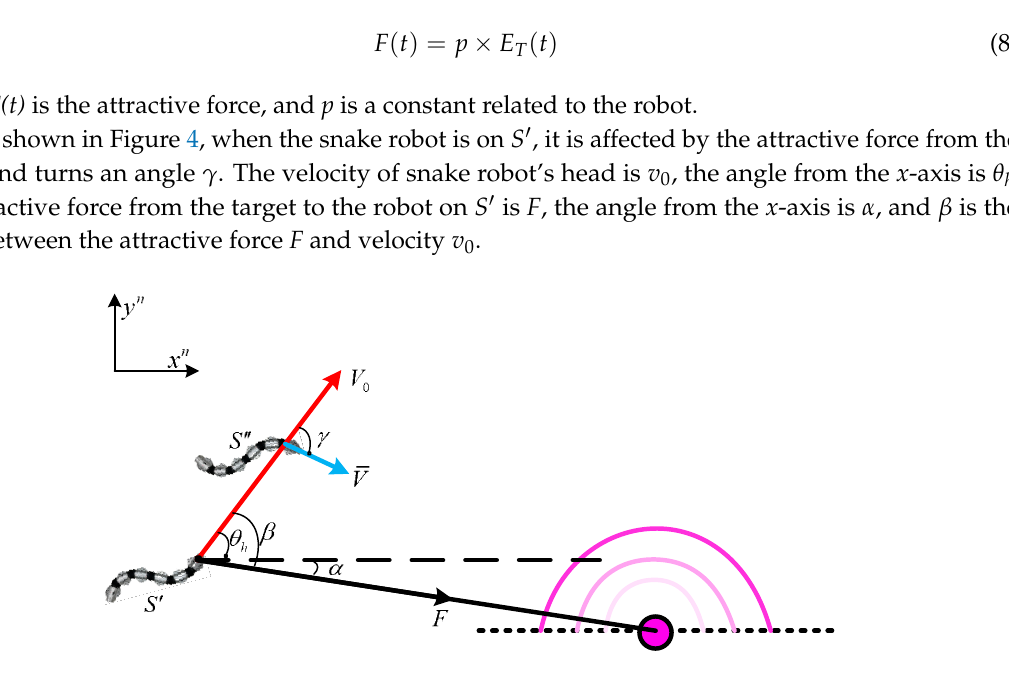
Figure 4. Relationship between the distance and the attractive force.